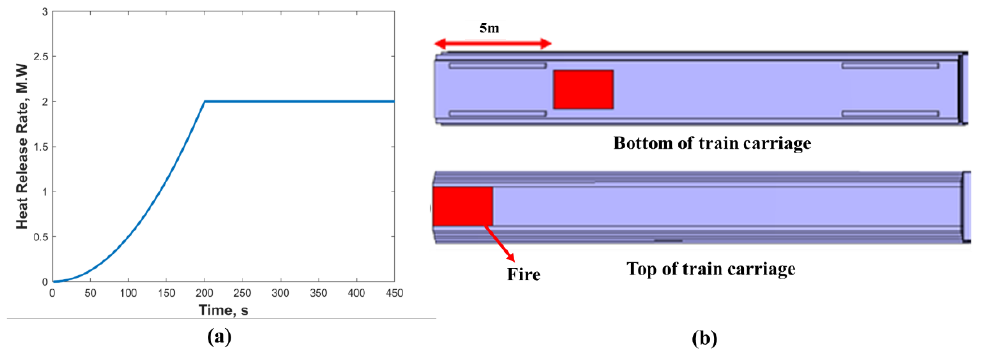
Figure 7. Fire profile including ( a ) heat release rate over time and ( b ) designated fire locations on the train carriage.